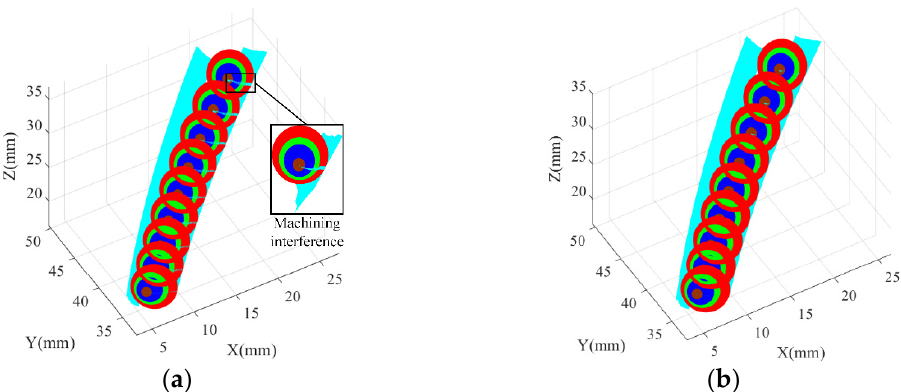
Figure 13. Machining process of finger milling cutter with double-arc: ( a ) Machining without error